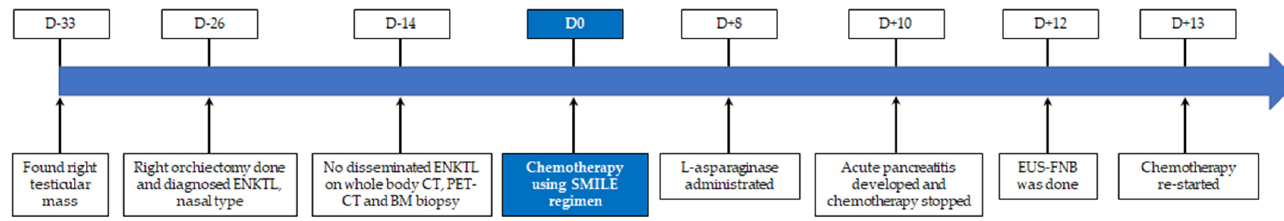
Figure 5. CT finding after 2 months. Pancreatitis is improved and no complication is observed. Figure 6. Patient’s hospital course with